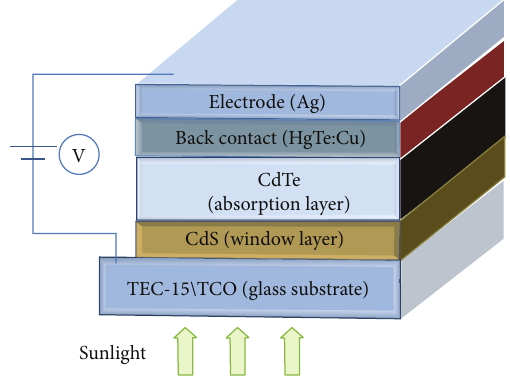
Figure 2: Superstrate configuration of the fabricated CdS/CdTe thin film solar